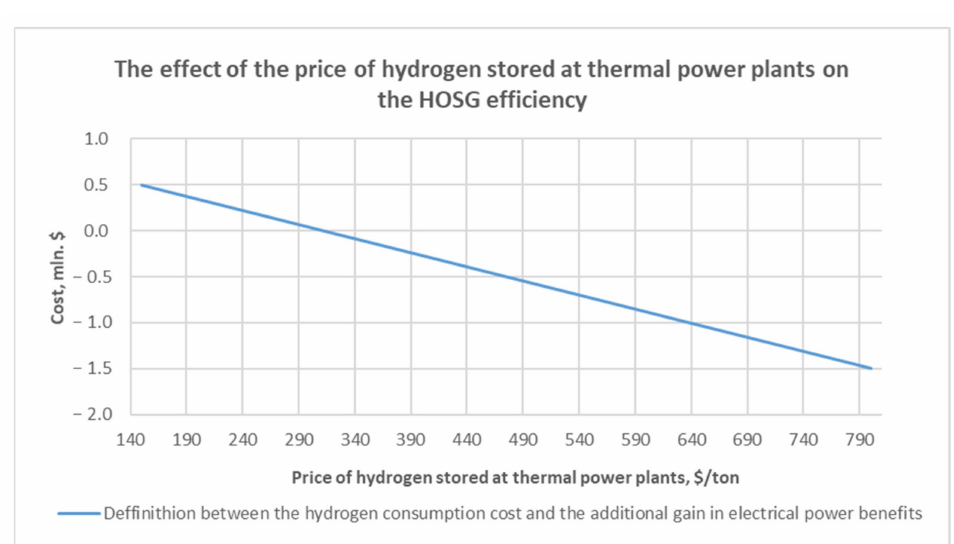
Figure 12. The effect of the price of hydrogen stored at thermal power plants on the HOSG efficiency in the case of superheating of the hot steam at the outlet of the boiler unit to the maximum currently possible temperature of 565 ◦ C.